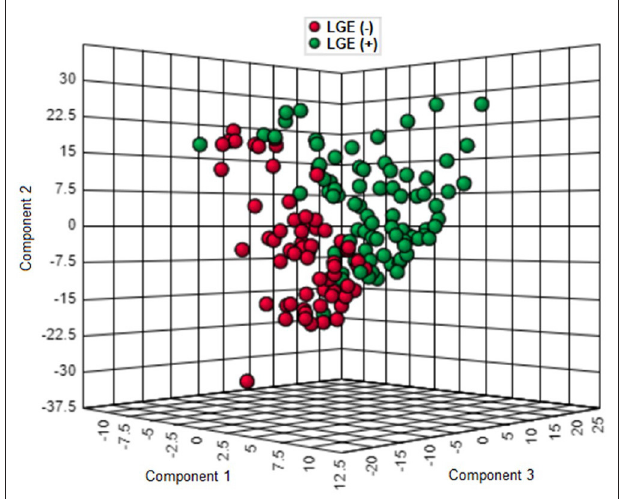
FIGURE 1 | Three-dimensional score plot of proteomics profiling in patients with and without late gadolinium enhancement in the hypertrophic cardiomyopathy population. Each green circle represents the proteomic profile of a patient with LGE. Each red circle corresponds to that of a patient without LGE. HCM, hypertrophic cardiomyopathy; LGE, late gadolinium enhancement.